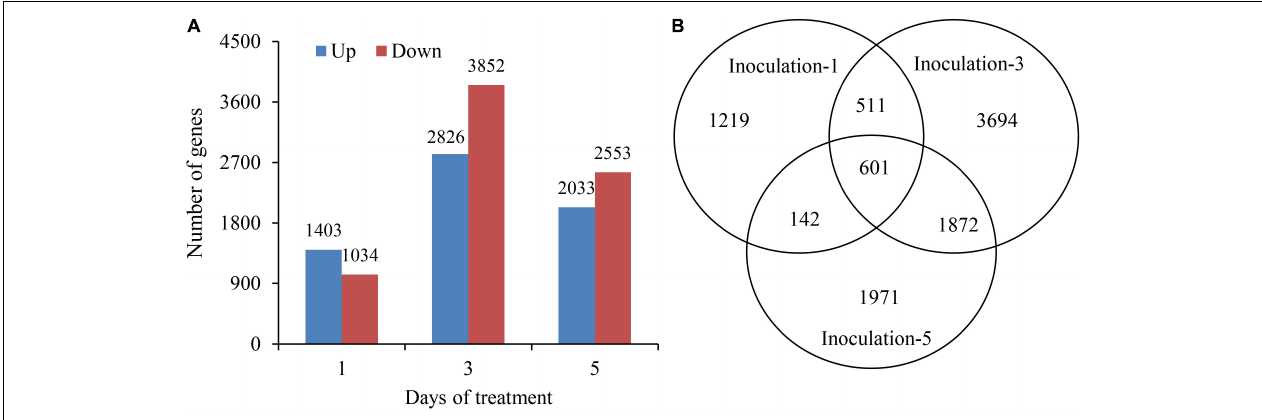
FIGURE 5 | Summary of differentially expressed genes at 1st, 3rd, and 5th days after inoculation. (A) Up and down regulated differentially expressed genes. (B) Venn diagram showing the differentially expressed gene at all three sampling conditions.